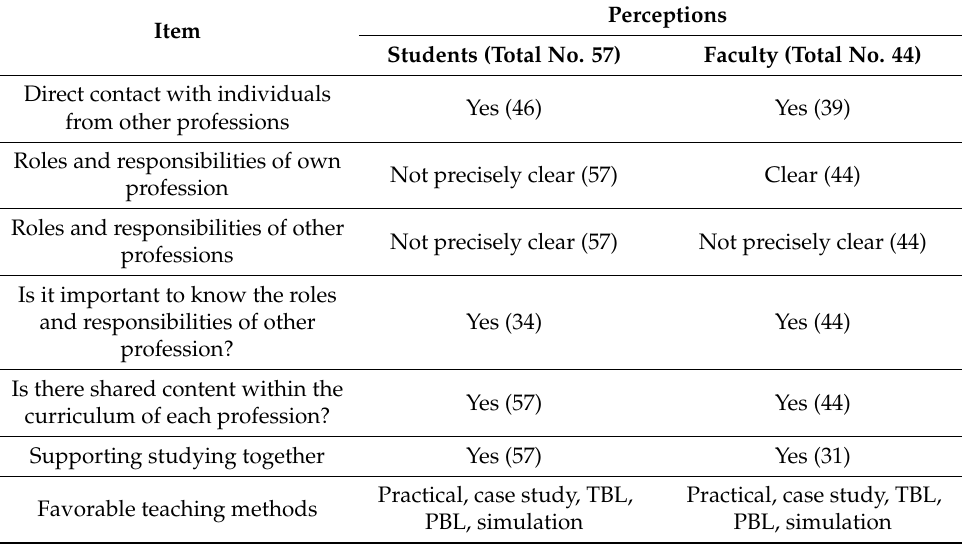
Table 5. Summary of responses by students and faculty members to focus group